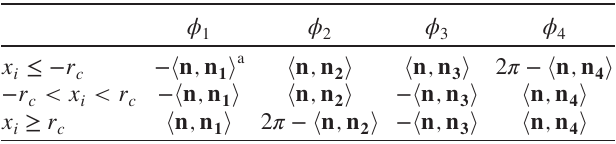
III. Angles ϕ 1 ∼ ϕ 4 for calculating the semicircular